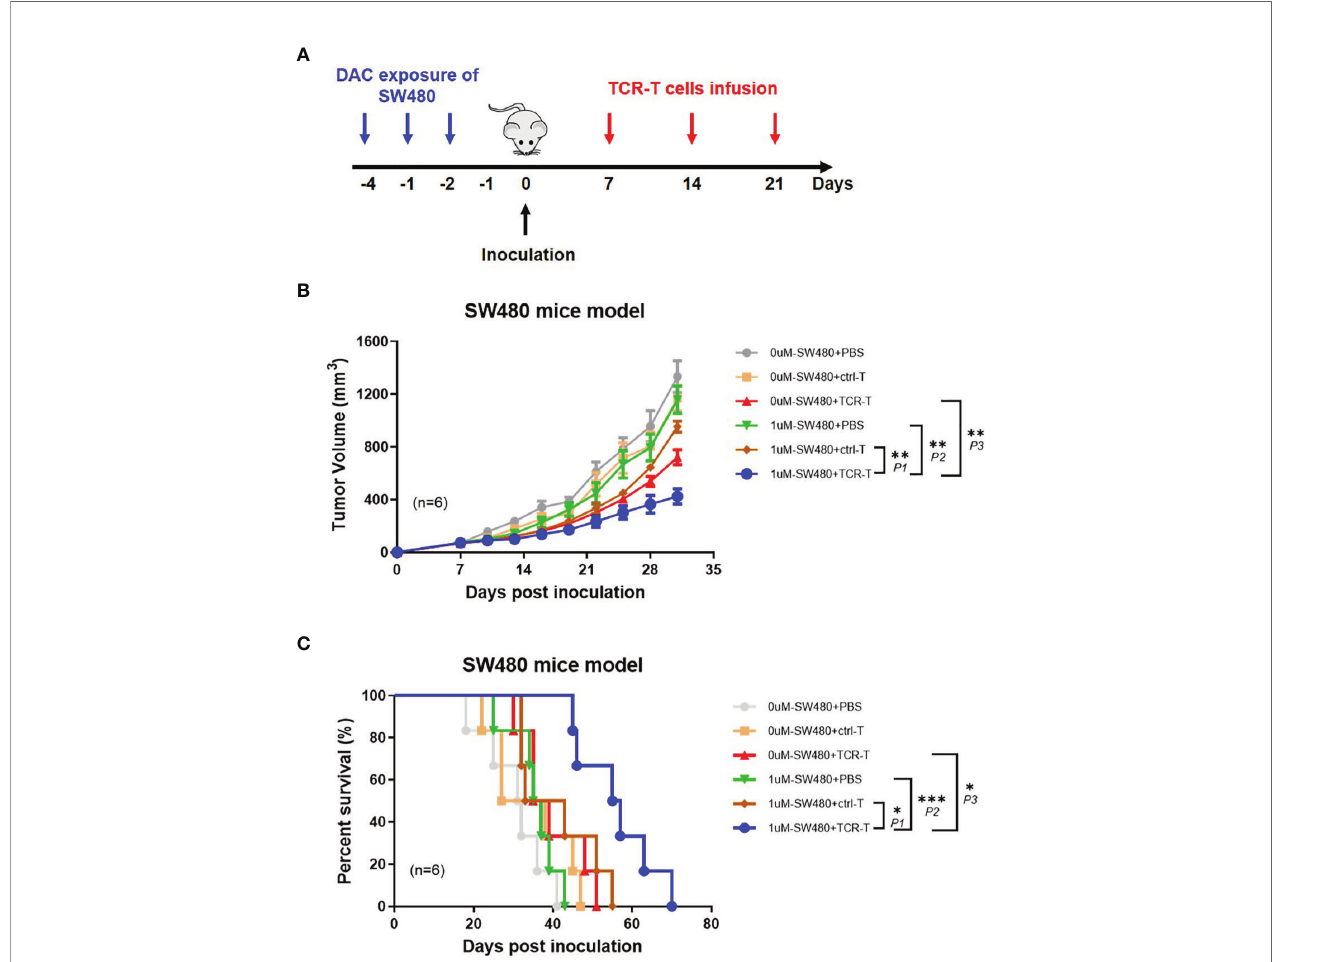
FIGURE 5 | Adoptively transferred TCR-T cells more remarkably inhibit the growth of DAC pre-treated tumor expressing NY-ESO-1 and HLA-A2 in vivo . (A) The schematic layout. NPG mice (NOD-Prkdc scid Il2rg null ) were inoculated with DAC treated or untreated SW480 cells, and then transferred with PBS, the ctrl-T cells or the TCR-T cells as indicated in Materials and Methods. (B) Tumor growth curves. Tumor growth was monitored by measuring the diameter of the tumor every 3 days and recorded as the tumor volume by formula: V= (L×W 2 )/2 (L and W represented the longest and shortest diameters). Bars, mean ± SD. P1 = 0.0032; P2 = 0.0014; P3 = 0.0073. (C) Survival rate of the tumor bearing mice. The survival curve was analyzed by log-rank test. P1 = 0.0243; P2 = 0.0005; P3 =